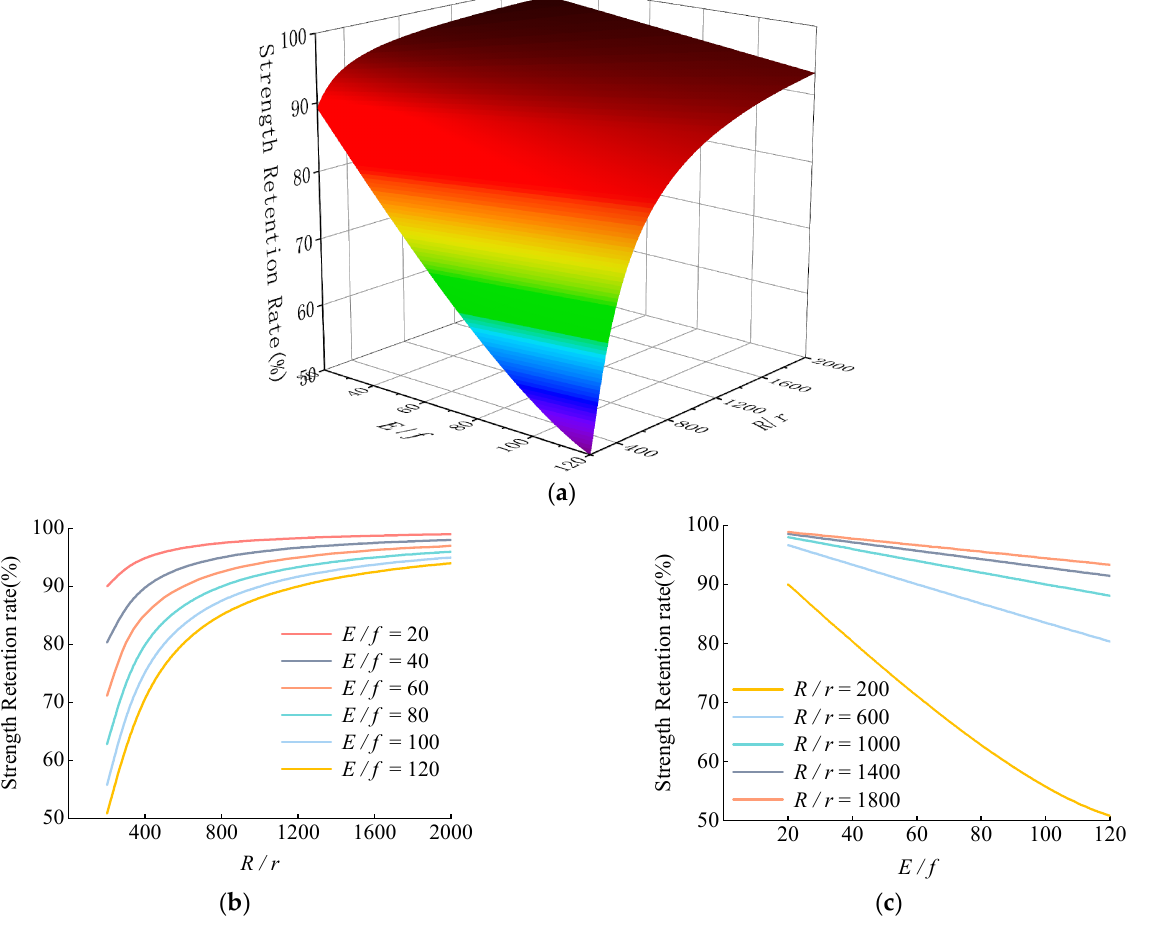
Figure 16. ( a ) Prediction model of residual strength under bending, ( b ) Effects of R/r on residual strength, ( c ) Effects of E/f on residual strength. Prediction model diagram.